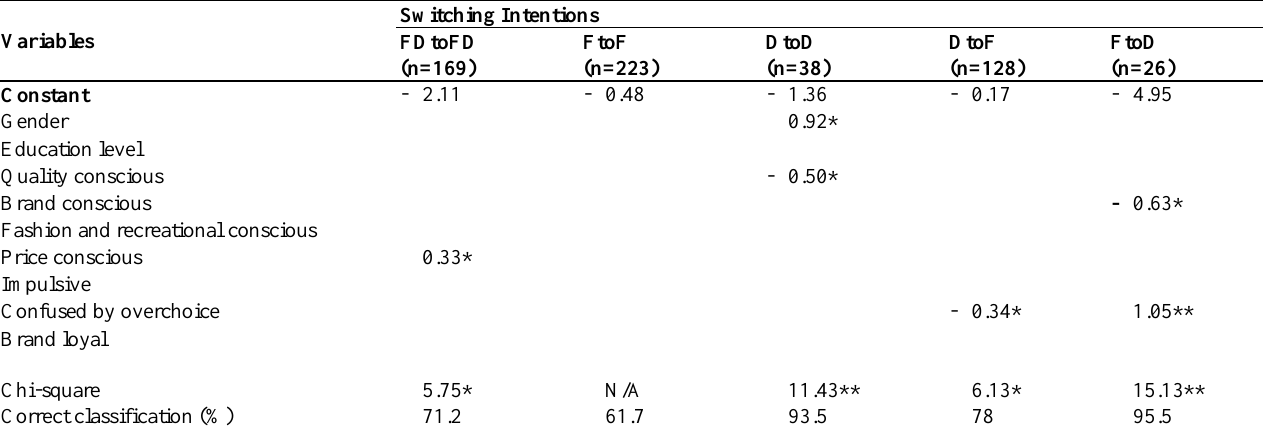
Table 4: Logistic regression results for decision-making styles by five cell phone switching intentions